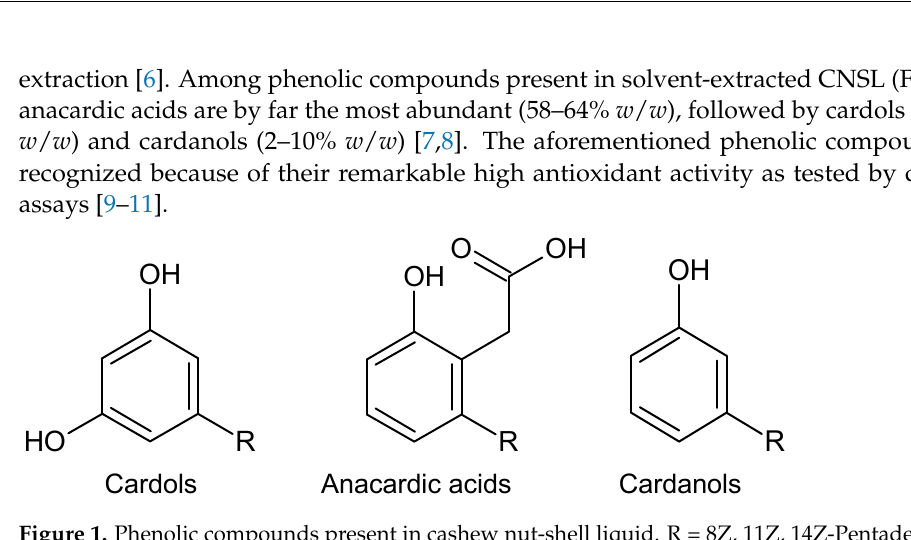
Figure 1. Phenolic compounds present in cashew nut-shell liquid. R = 8Z, 11Z, 14Z-Pentadecatrienyl; 8Z, 11Z-pentadecadienyl; 8Z-pentadecenyl; or pentadecyl Adapted from [7].